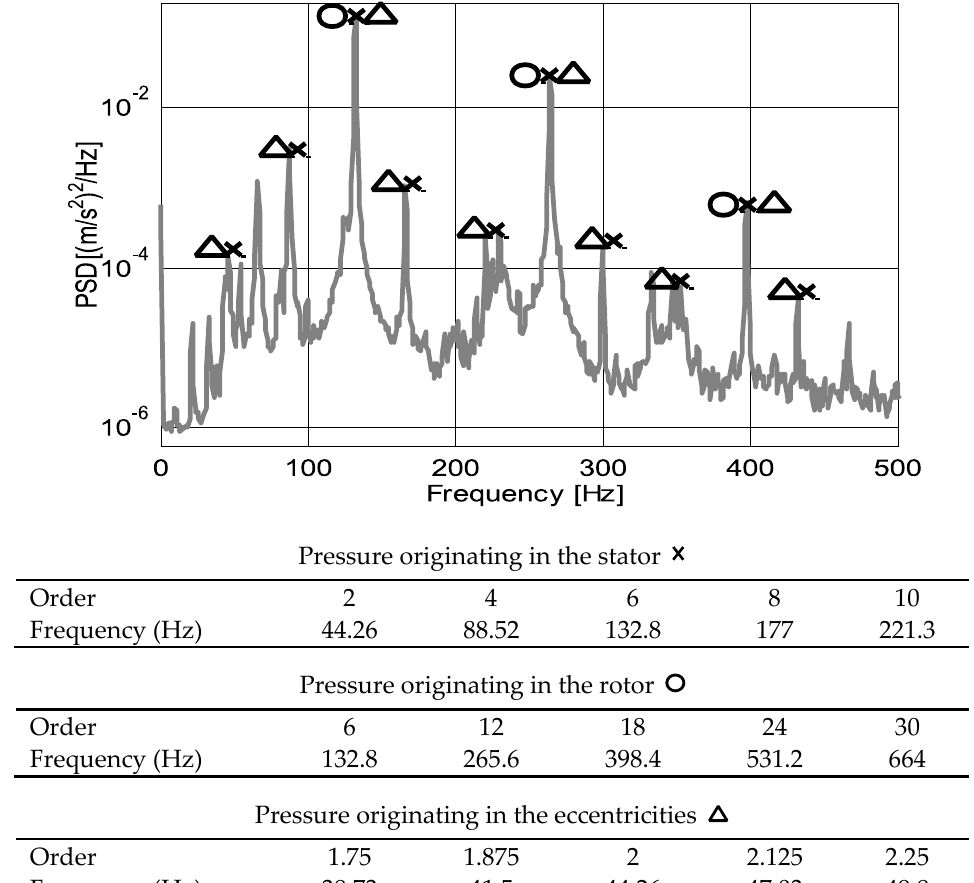
( b ) Figure 22. Forces created by the stator armature on the rotor surface: ( a ) Qs48p8, ( b ) Qs36p15. 4.2. Experimental Validation The analytical model was also validated by experimental measurements. Vibrations were measured in both prototypes shown in Figures 23 and 24 by placing an accelerome- ter on the outer surface of the stator. The Figures 25 and 26 show that the developed ana- lytical expressions characterized the order and the origin of the various electromagnetic vibrations with accuracy. In the integer machine, all harmonics were integer, and in the fractional machine, fractional harmonics were clearly seen. These harmonics originate on the rotor surface and they are transmitted to the stator surface, for example through the bearings. The magnitudes of the harmonics could not be validated with the obtained experi- mental results. This issue is a future prospect; it would be interesting to conduct additional research in order to experimentally validate the magnitudes of these magnetic forces.